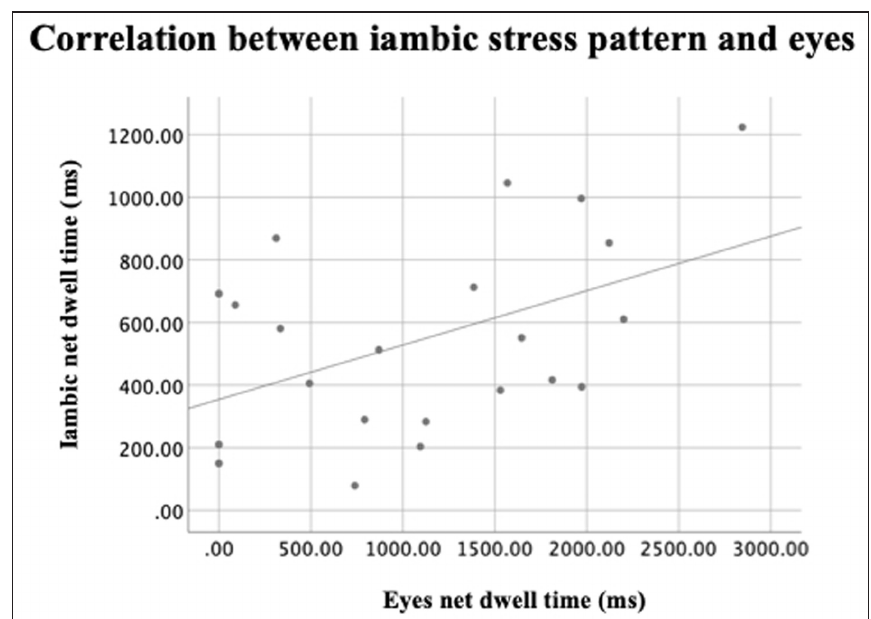
Figure 5: Correlation between looking time (net dwell time – ms) to the iambic stress pattern and eye gaze (net dwell time – ms) to the